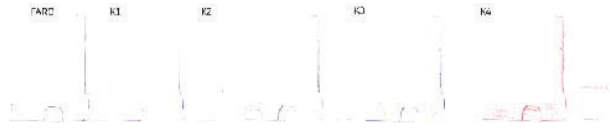
Figure 5. Section line comparison between different scan slots.